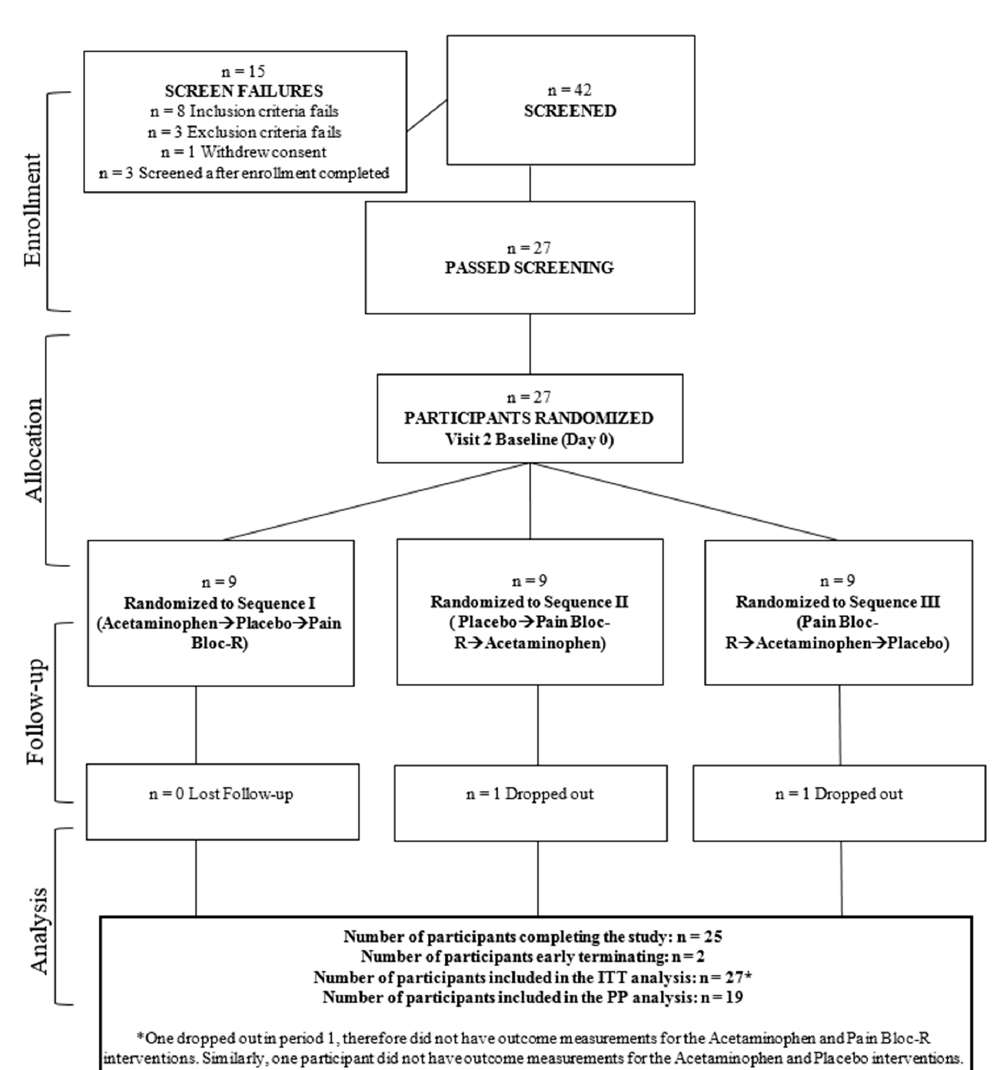
Figure 2. Disposition of study participants.